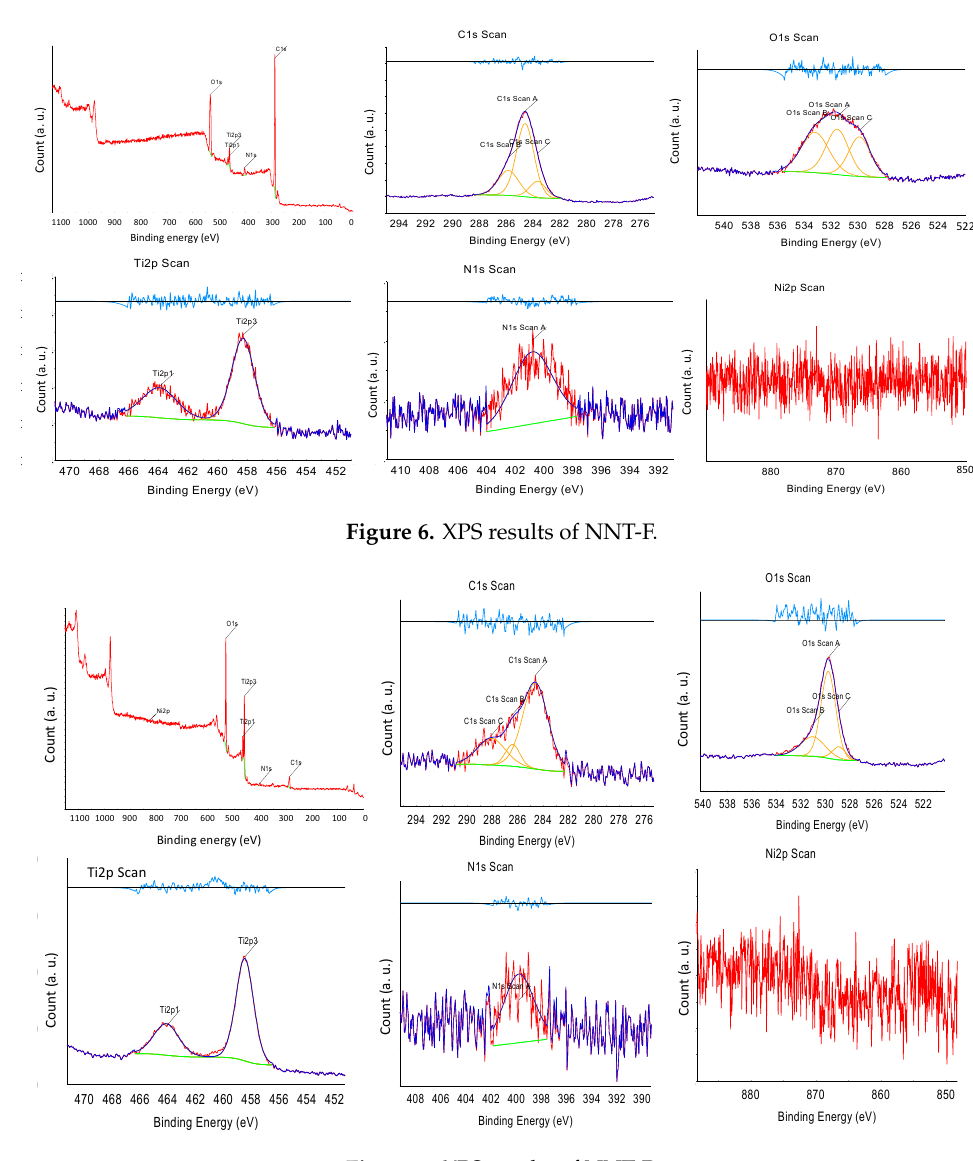
Figure 7. XPS results of NNT-P.